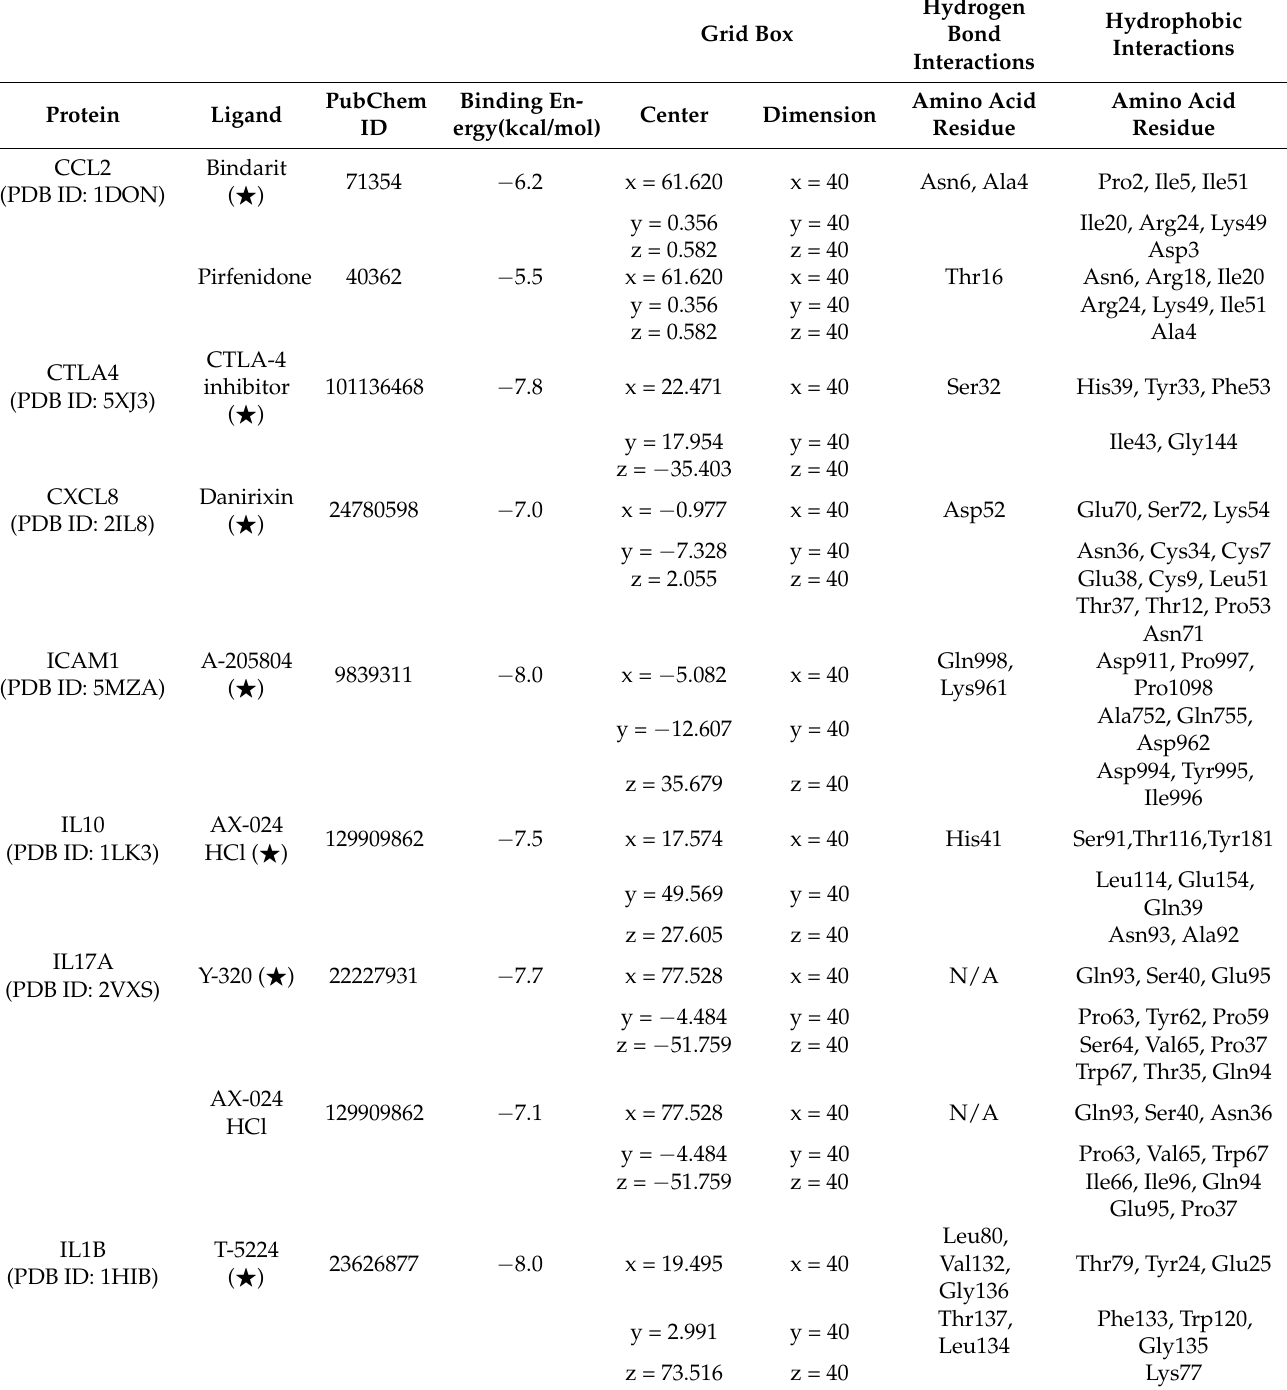
Table 3. The binding energy of the eight targets related to eight ligands in the top 30% by betweenness centrality (BC).